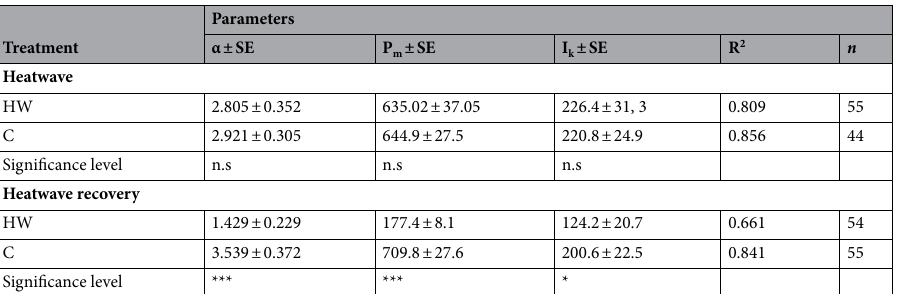
Table 1. C. nodosa’s photosynthetic parameters obtained after fitting the data with the Jassby & Platt (1976) P-I model. Mean photosynthetic quantum efficiency (α; μmol O 2 gDW −1 h −1 /μmol photons m −2 s −1 ),